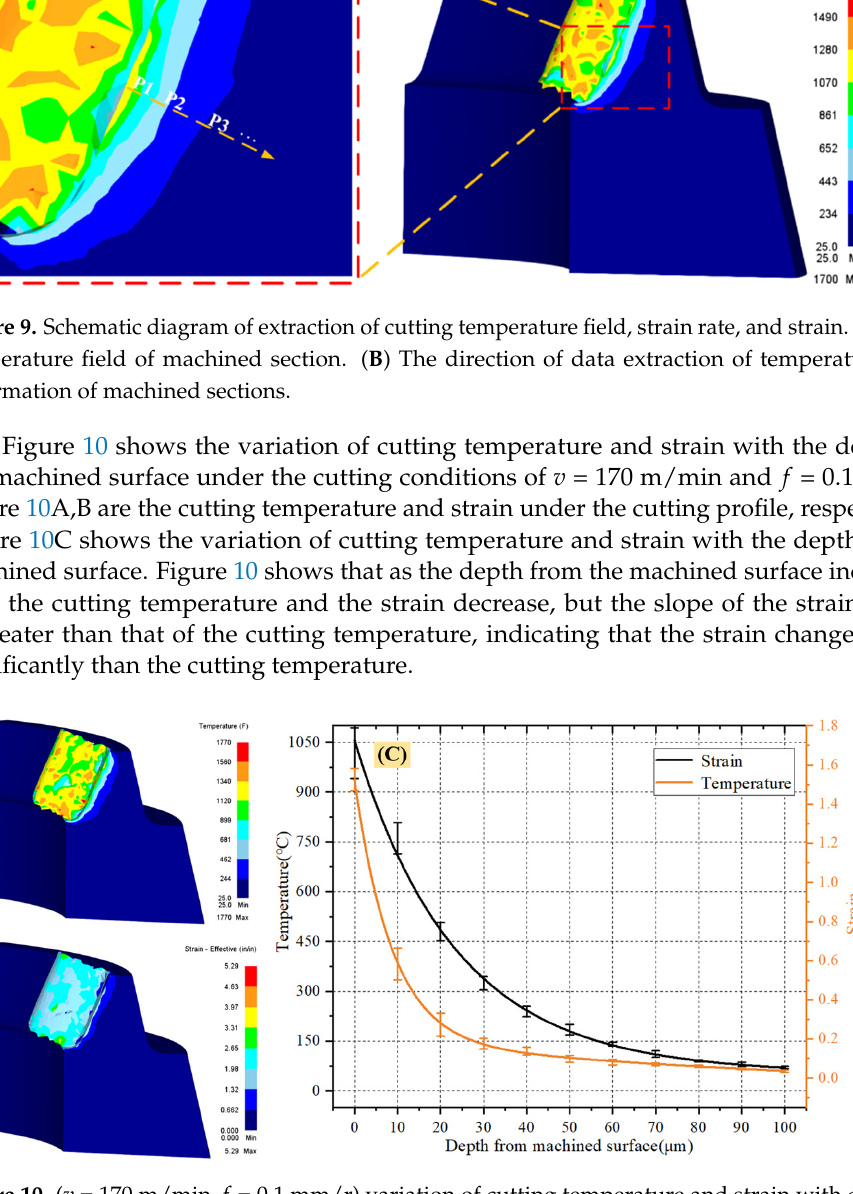
Figure 10. ( 𝑣 = 170 m/min, 𝑓 = 0.1 mm/r) variation of cutting temperature and strain with depth of machined surface (( A ) shows the temperature field of the cutting section, ( B ) shows the strain field of the cutting section, and ( C ) shows the variation of cutting temperature and strain with the depth of the machined surface).